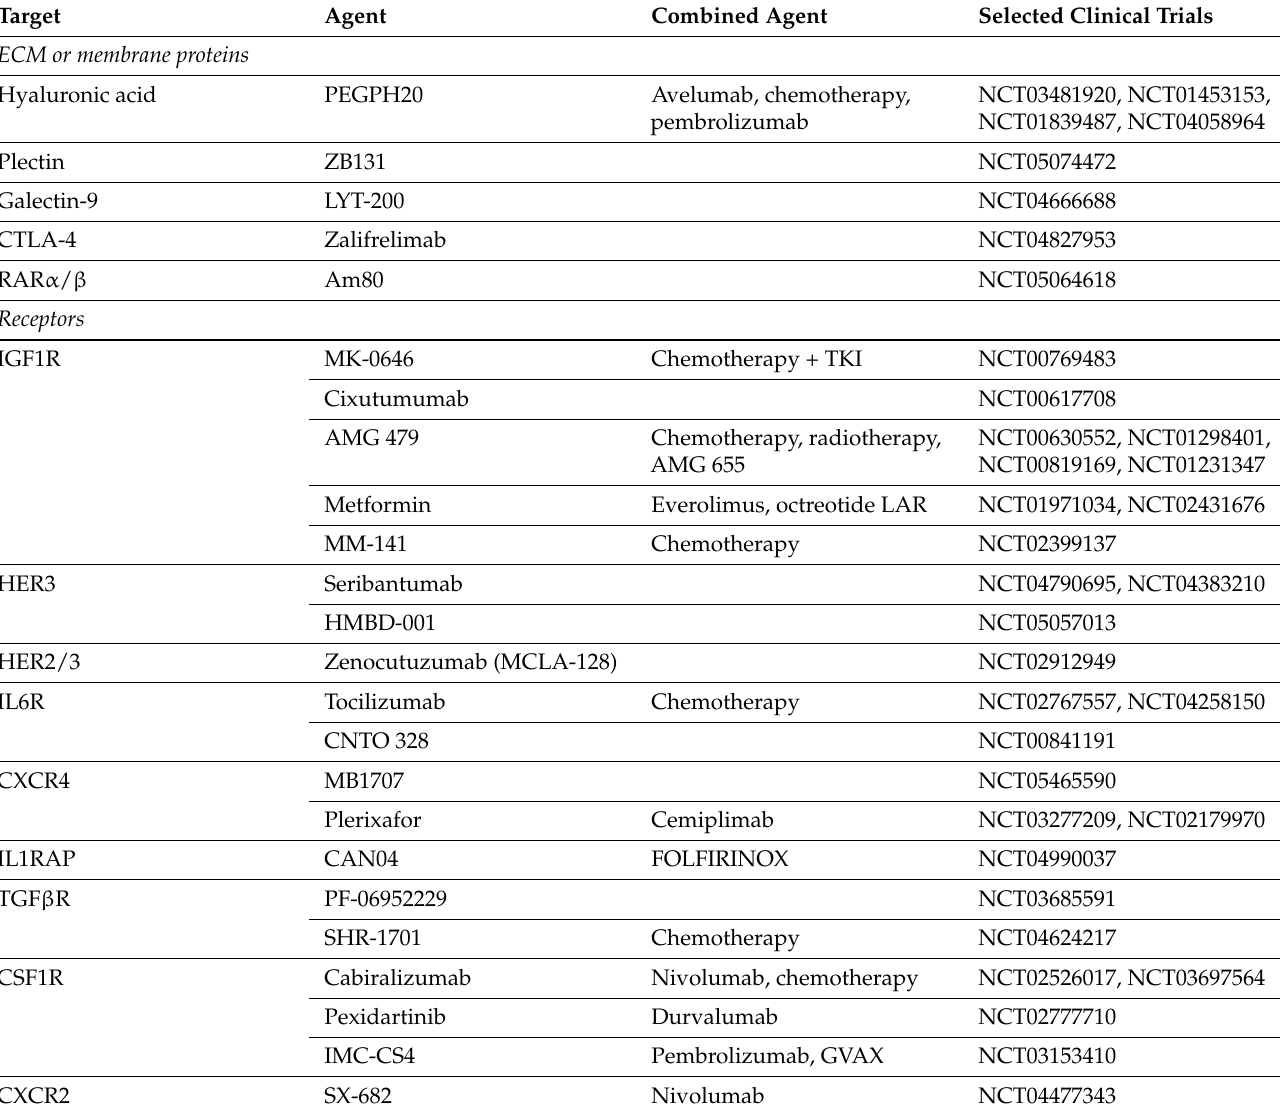
Table 2. Summary of representative clinical trials targeting TME in pancreatic